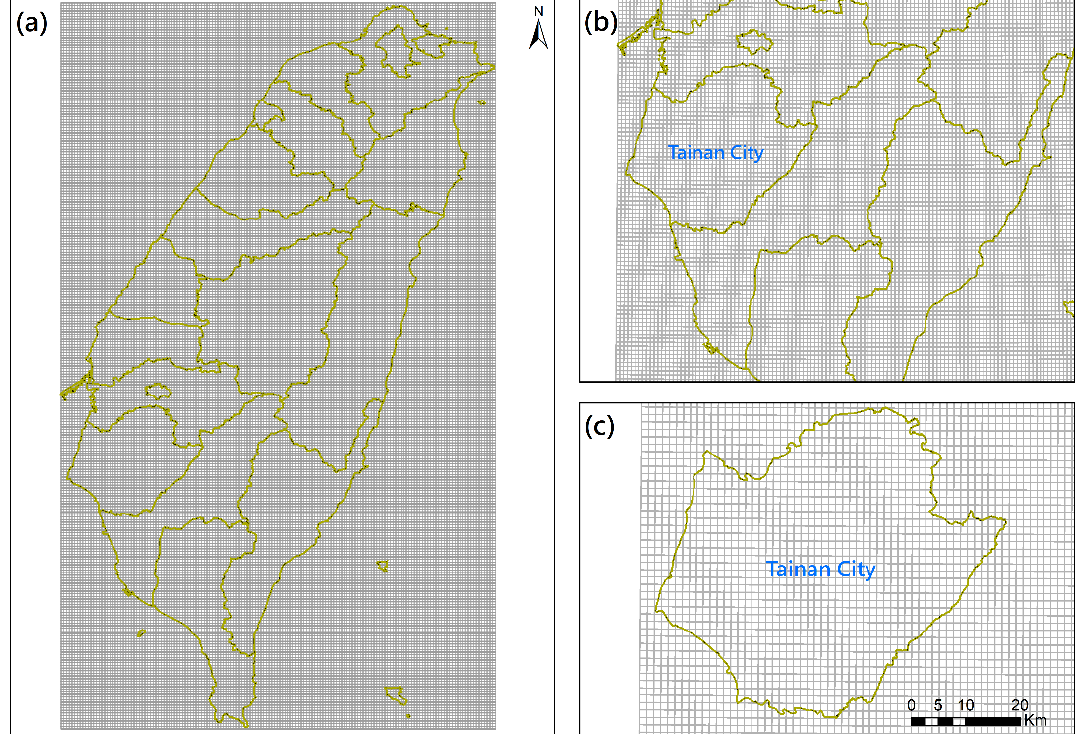
Figure 4. Spatial distribution of gridded rainfall data with a 1.25 km resolution for ( a ) all of Taiwan, ( b ) an enlargement of southern Taiwan, and ( c ) an enlargement of Tainan city.